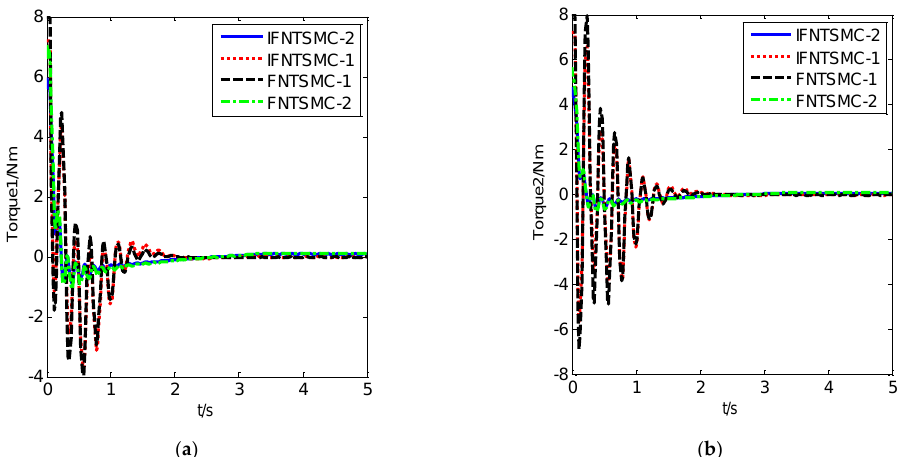
Figure 3. Input torque of the controller. ( a ) Input torque of joint 1, ( b ) Input torque of joint 2.